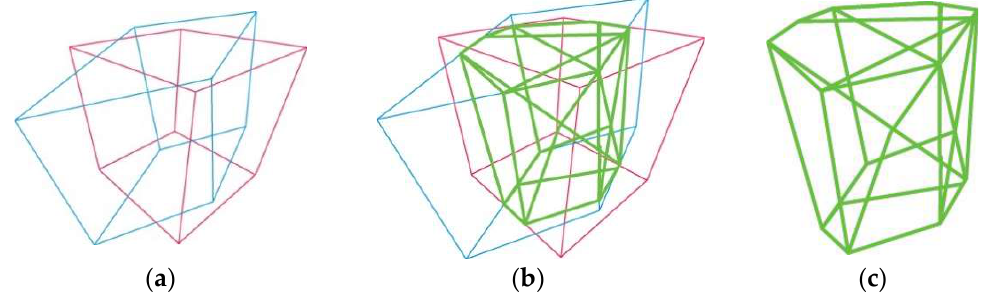
Figure 6. 3D IoU with pink and blue lines boxes: ( a ) clipping the polygon to the box to calculate the intersection of each side; ( b ) calculating the intersection volume using the convex hull algorithm of all intersections (green); ( c ) 3D IoU.